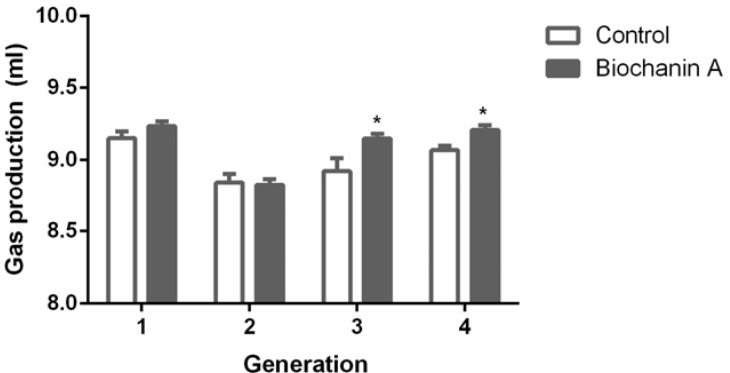
Figure 4. The effect of biochanin A on gas production in anaerobic medium. Treatments included controls (only DMSO) and anaerobic medium with exogenous addition of biochanin A. Asterisks (*) indicate a significant difference between treatments ( p < 0.05). Error bars represent SEM.